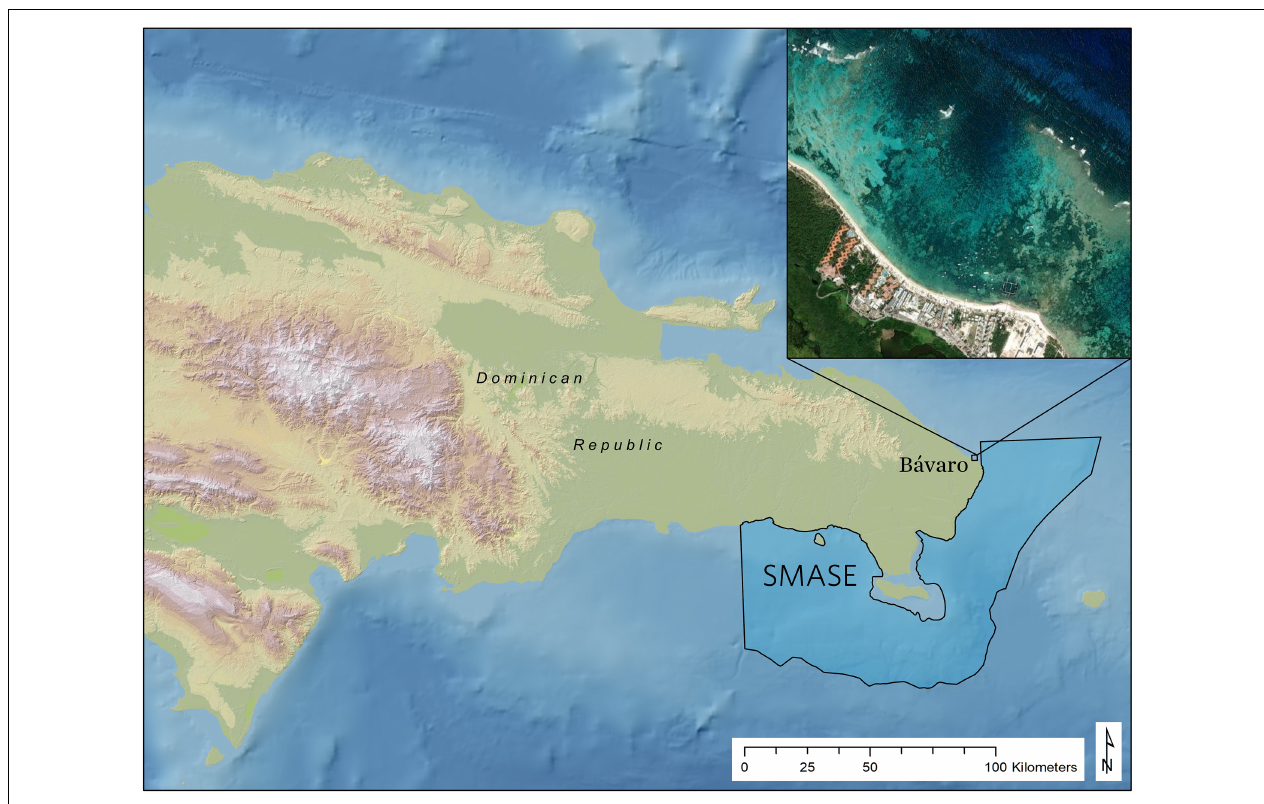
FIGURE 1 | Reference map showing the location of the outplant locations in Bávaro near the South East Marine Sanctuary (SMASE: Santuario Marino Arrecifes del Sureste), the second largest protected area in the Dominican Republic where the Global Airborne Observatory (GAO) acquired imaging spectrometer data in May